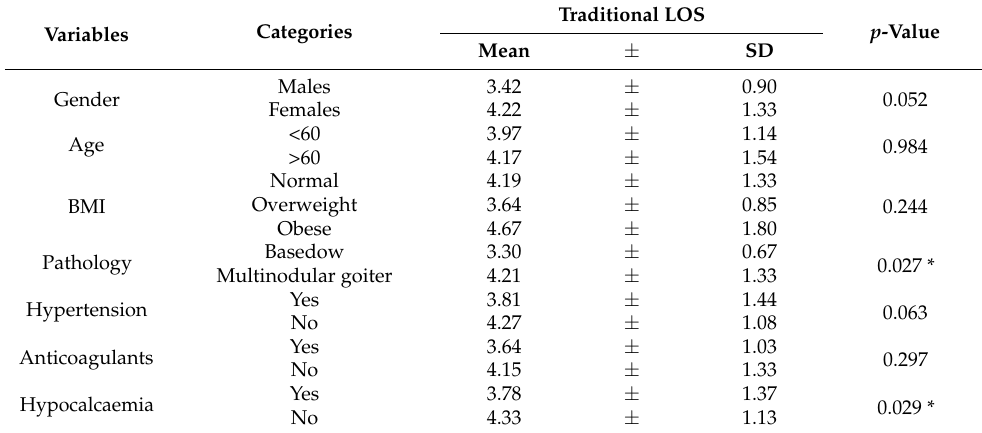
Table 2. Analysing variables influencing LOS for traditional group. Statistically significant results (significance level = 0.05) = *. Abbreviation: BMI: Body Mass Index.